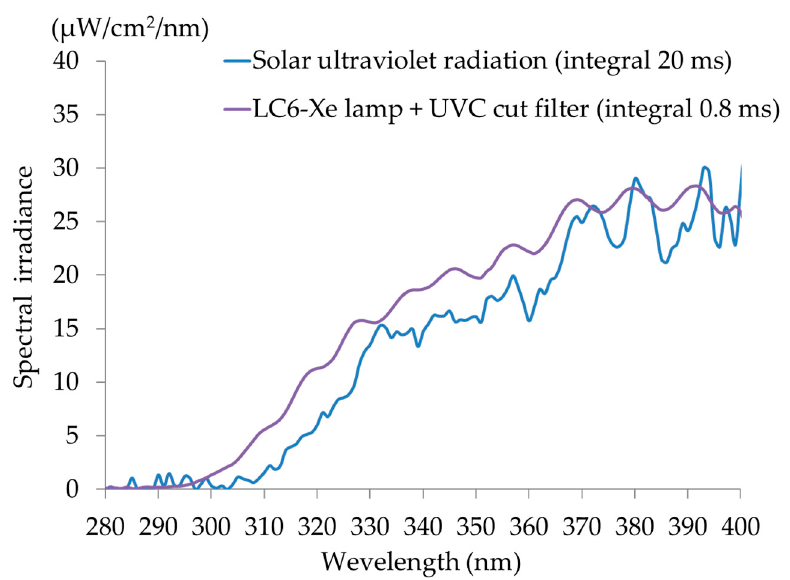
Figure 2. Spectral comparison of the energy of the Xe light source and the solar ultraviolet radiation.